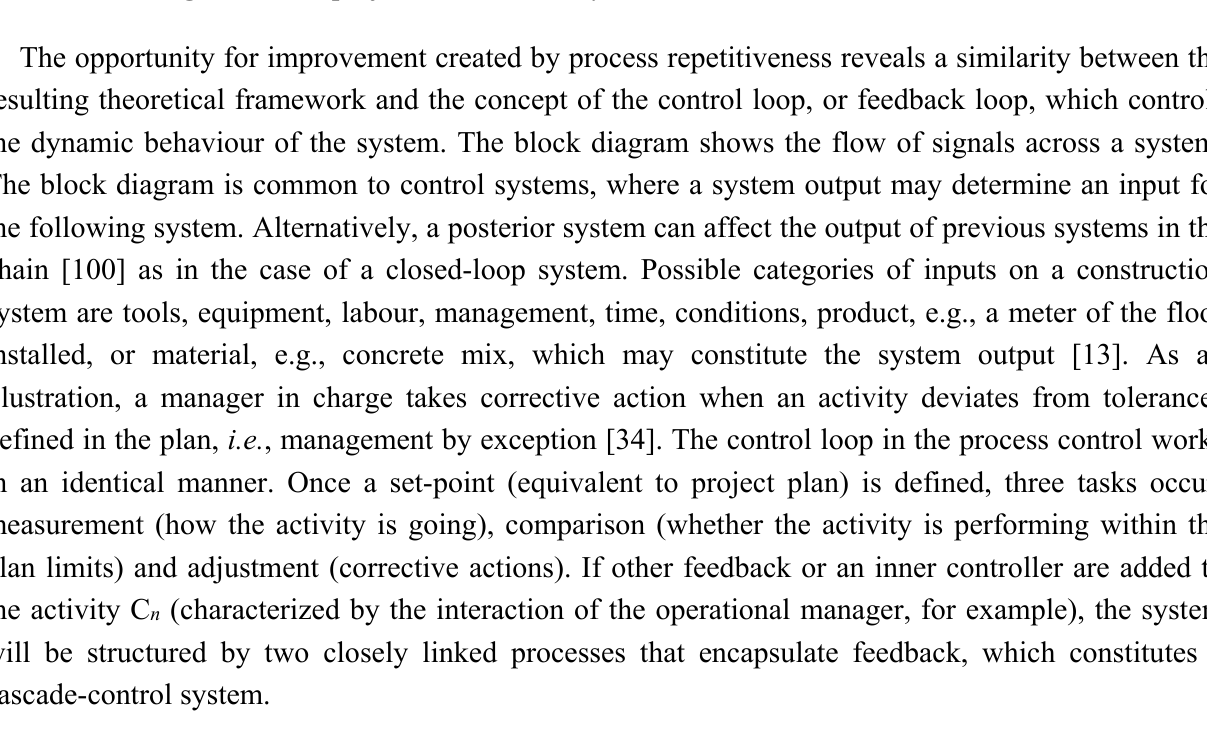
Figure 4. The project construction system from the theoretical